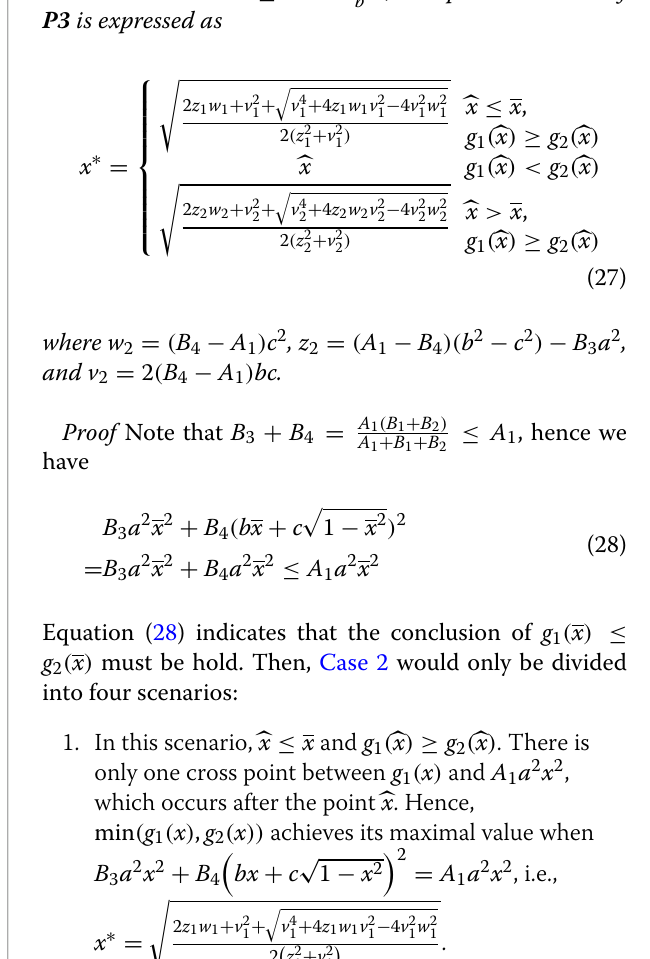
Fig. 4 a Case 1. b Case 2. c Case